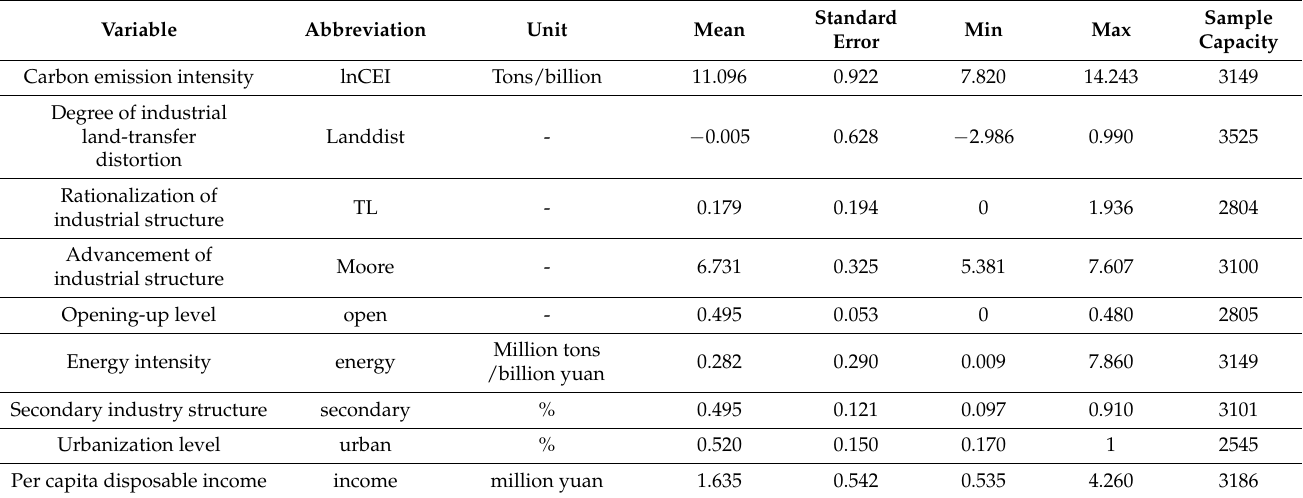
Table 1. Research data explanation and sources